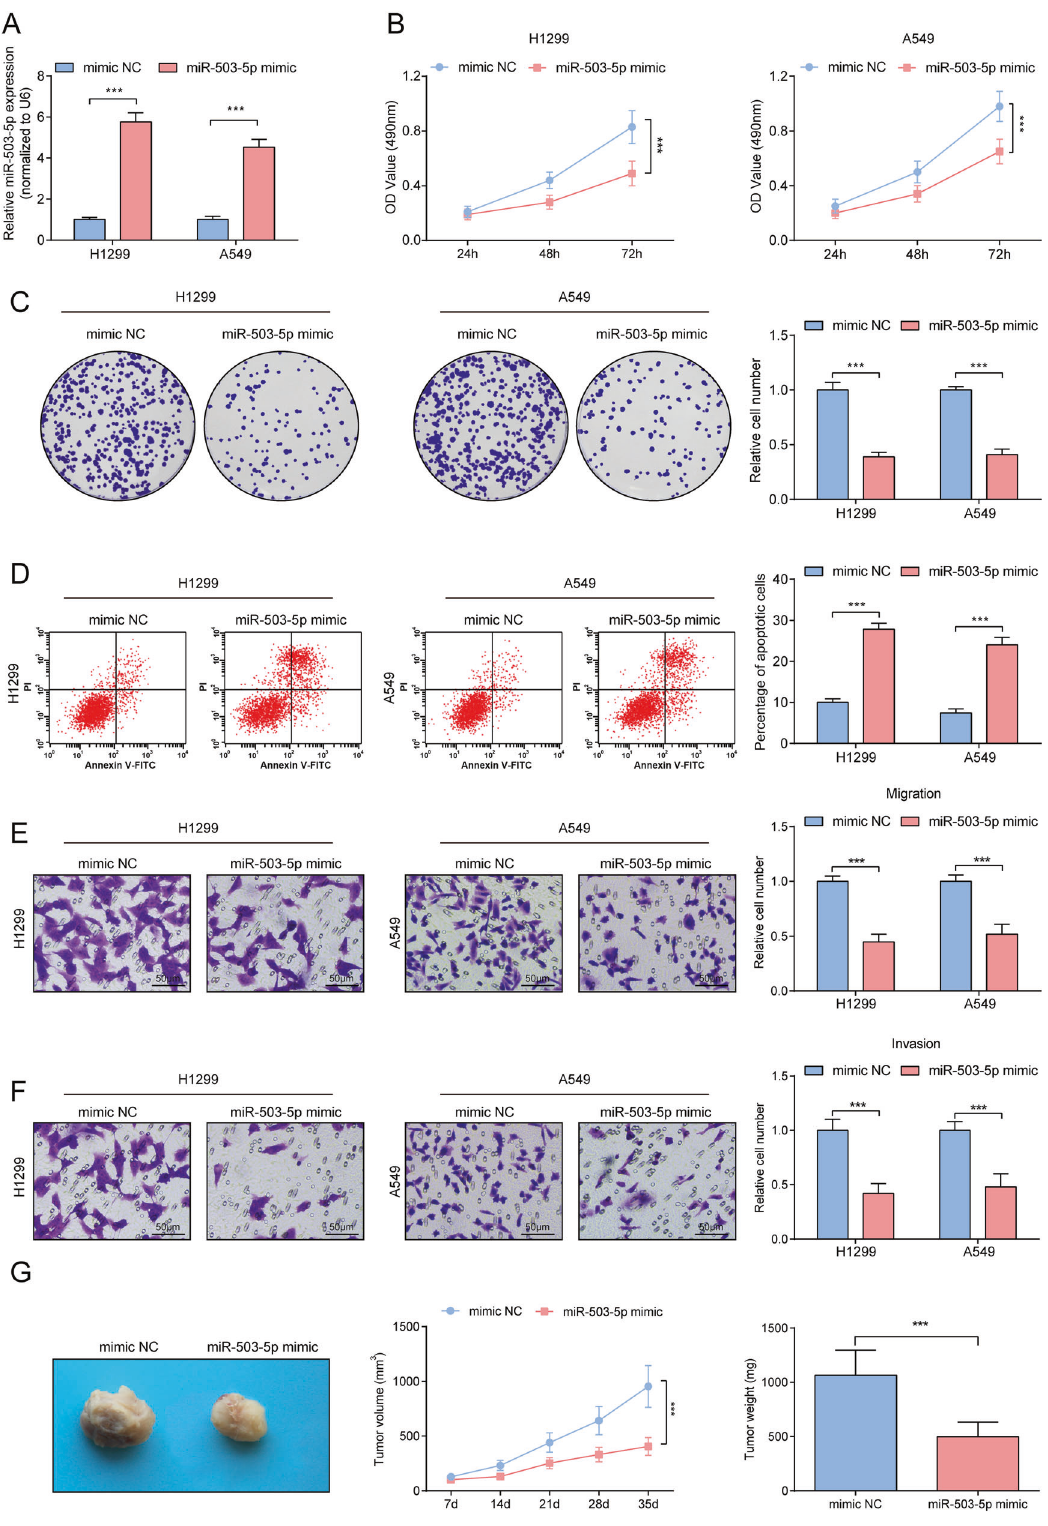
Fig. 4 Repressive effects of miR-503-5p on tumorigenicity of NSCLC. A RT-qPCR analysis of miR-503-5p level after upregulating miR-503-5p. B MTT measured the growth curve of A549 and H1299 cells after upregulating miR-503-5p. C Colony formation assay measured colony formation ability of A549 and H1299 cells after upregulating miR-503-5p. D Flow cytometry measured A549 and H1299 cell apoptosis after upregulating miR-503-5p. E , F Transwell measured cell migration and invasion ability after upregulating miR-503-5p. G Tumor formation assay evaluated tumor volume and weight after upregulating miR-503-5p. *** P < 0.001; Data statistics was by t -test.